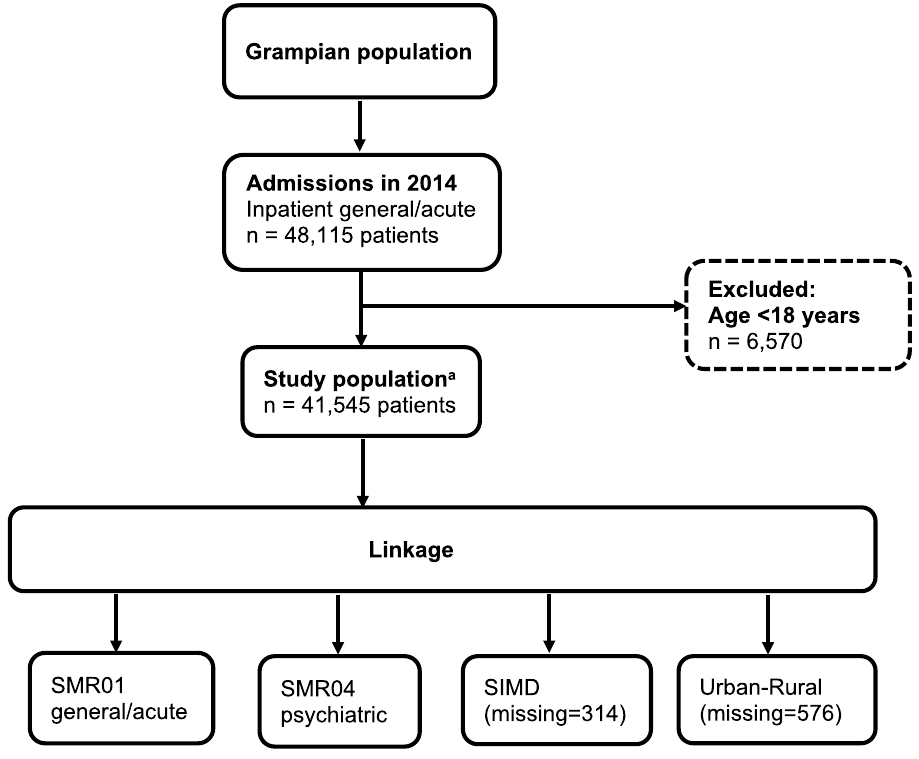
Figure 1. Flowchart of study population and data linkage. SMR, Scottish Morbidity Record; SIMD, Scottish Index of Multiple Deprivation. a Community Health Index number was missing or invalid for 662 inpatient general/acute admissions in 2014 (patients ≥ 18 years), therefore not included in the study